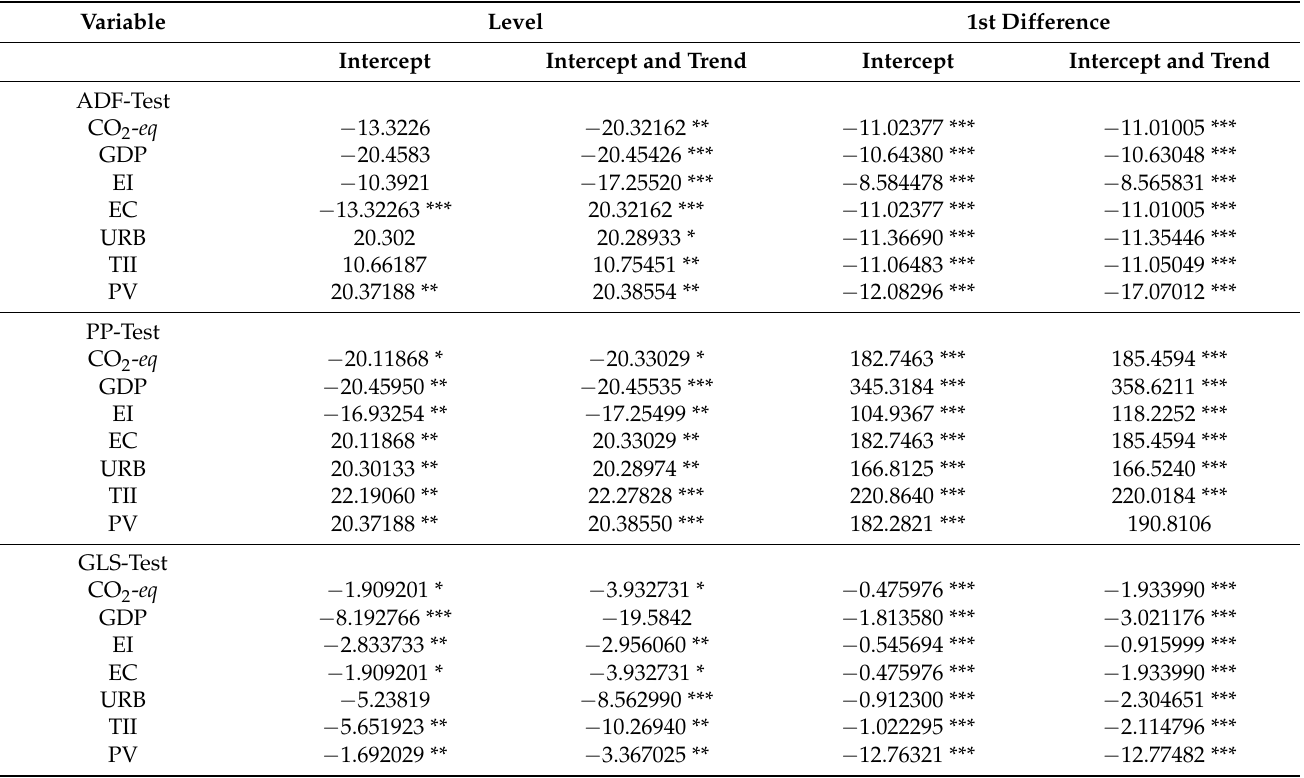
Table 6. Results of panel unit root test.